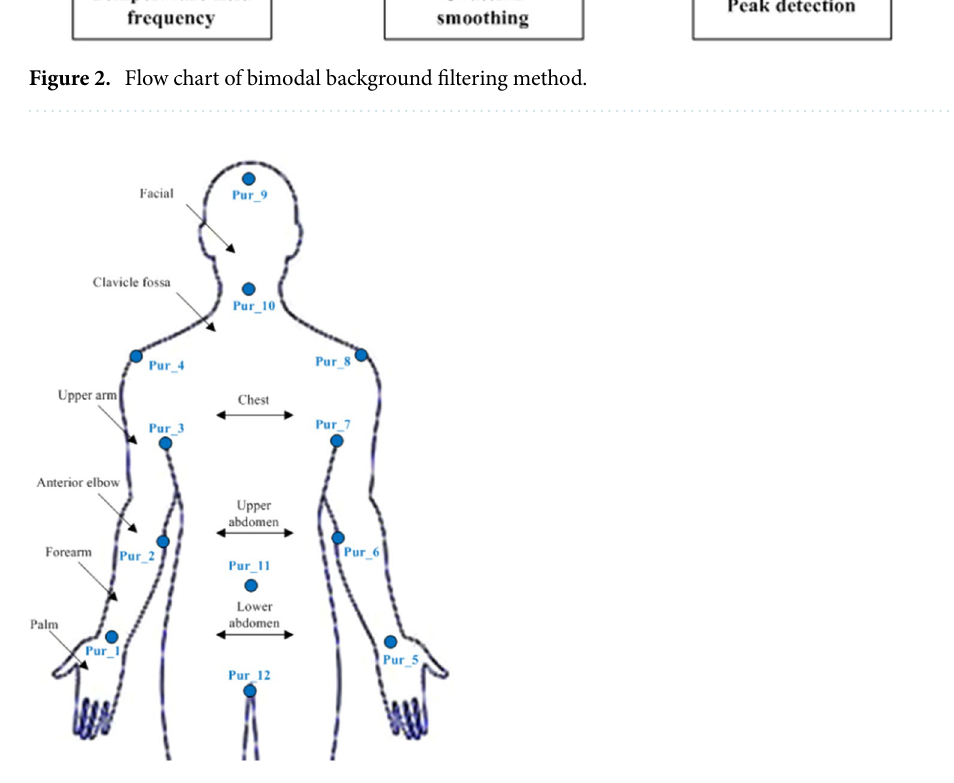
Figure 3. The region segmentation target.